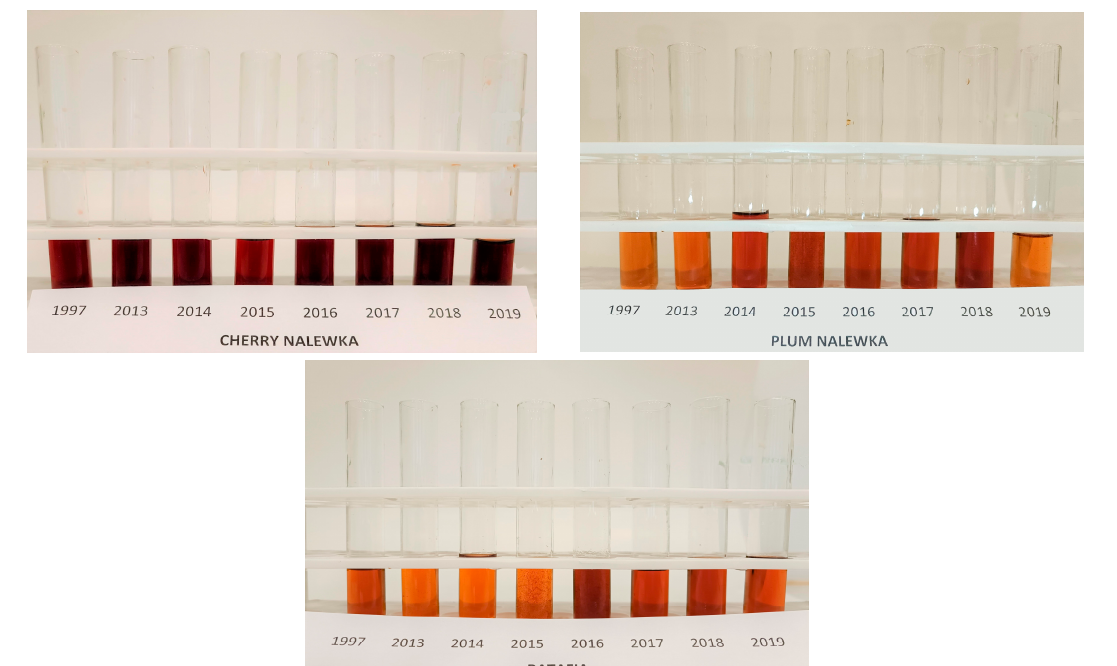
Figure 1. The nalewkas from all years of production.